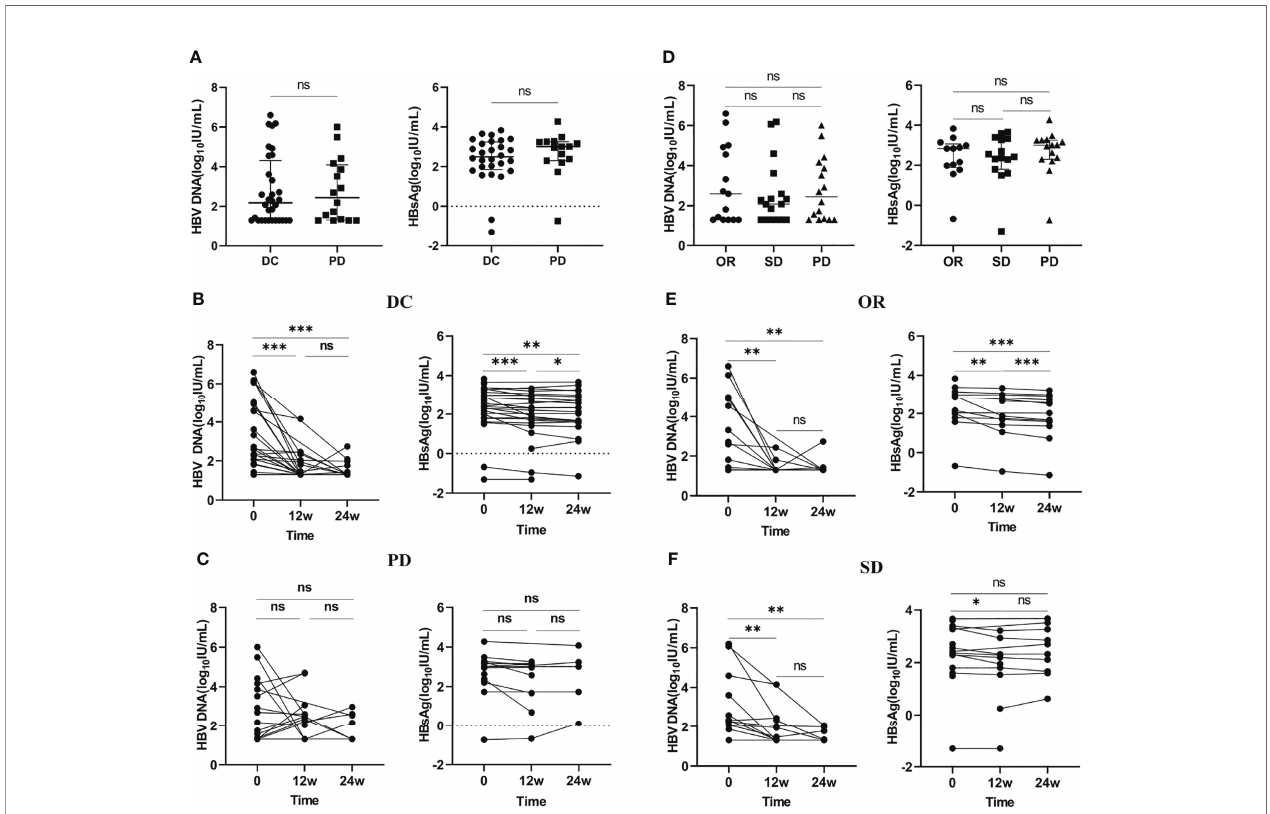
FIGURE 2 | The change in HBV DNA and HBsAg levels in patients with different tumor responses. (A) Comparison of baseline levels of HBV DNA and HBsAg between patients with DC and PD. (B) The changes in HBV DNA and HBsAg levels at different time points in patients with DC. (C) The changes in HBV DNA and HBsAg levels at different time points in patients with PD. (D) Comparison of baseline levels of HBV DNA and HBsAg among patients with OR, SD and PD. (E) The changes in HBV DNA and HBsAg levels at different time points in patients with OR. (F) The changes in HBV DNA and HBsAg levels at different time points in patients with SD. DC, disease control; OR, objective response; PD, progressive disease; SD, stable disease. ns: >0.05; ***: ≤ 0.005; **: ≤ 0.01; *: ≤